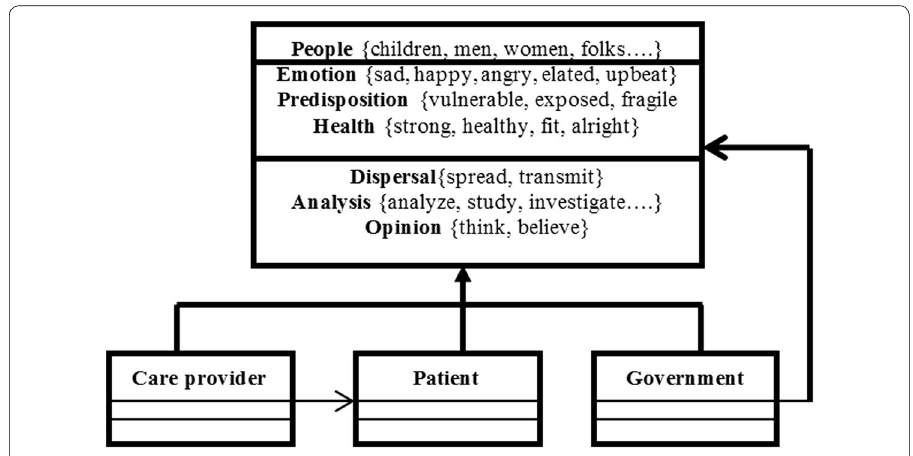
Fig. 3 People object sub hierarchy with corresponding concept dictionaries indicated in curly